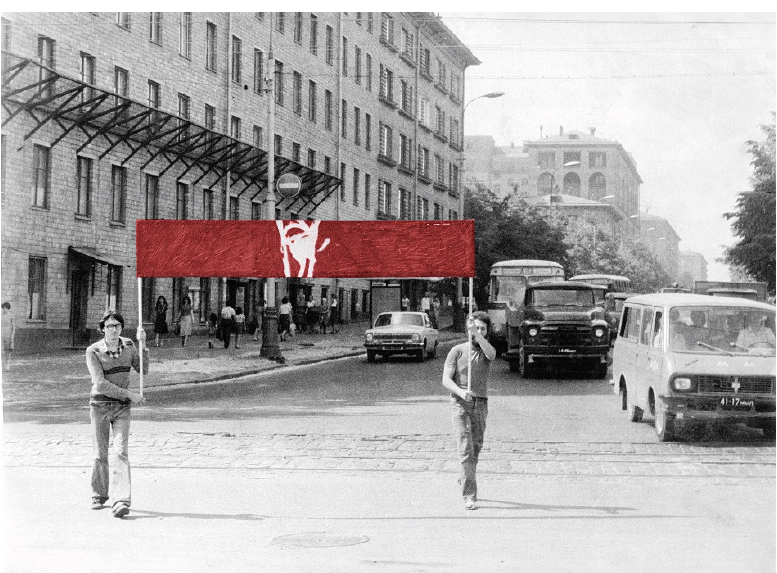
Figure 7. The Nest. Art to the Masses . 1978. Hand-colored photograph. 70 × 90. Image courtesy of Victor Skersis. Photograph by Valentin Serov.